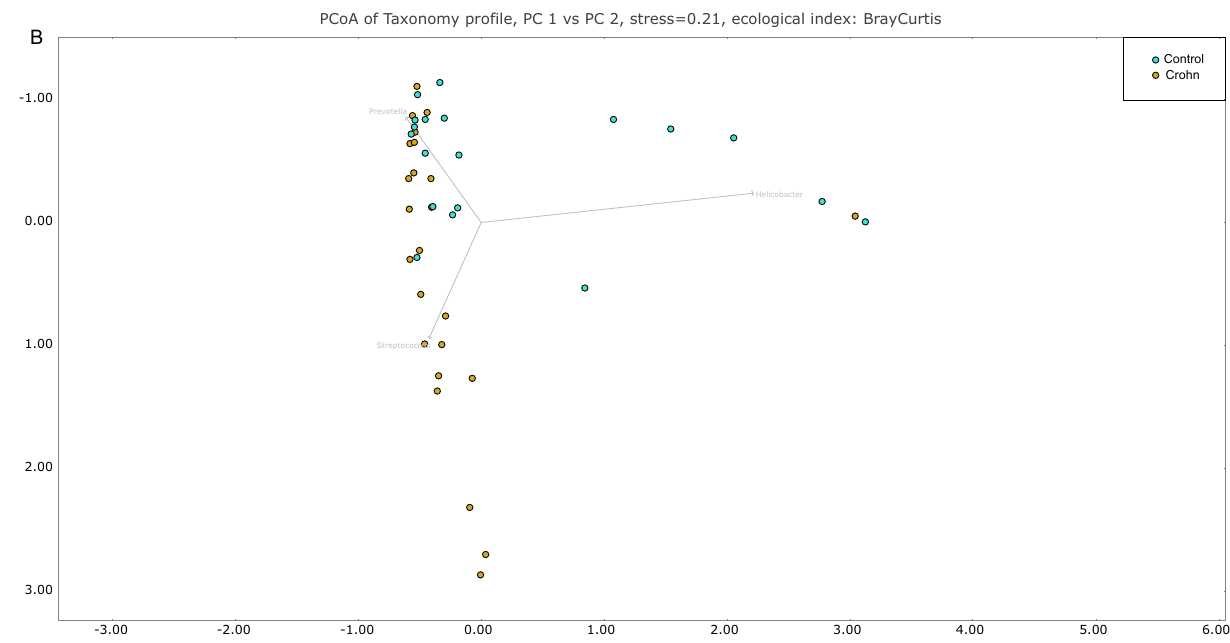
Figure 1. Principal coordinates analysis of all studied samples using the Bray–Curtis index as a distance measure. ( A ) Corpus; ( B )